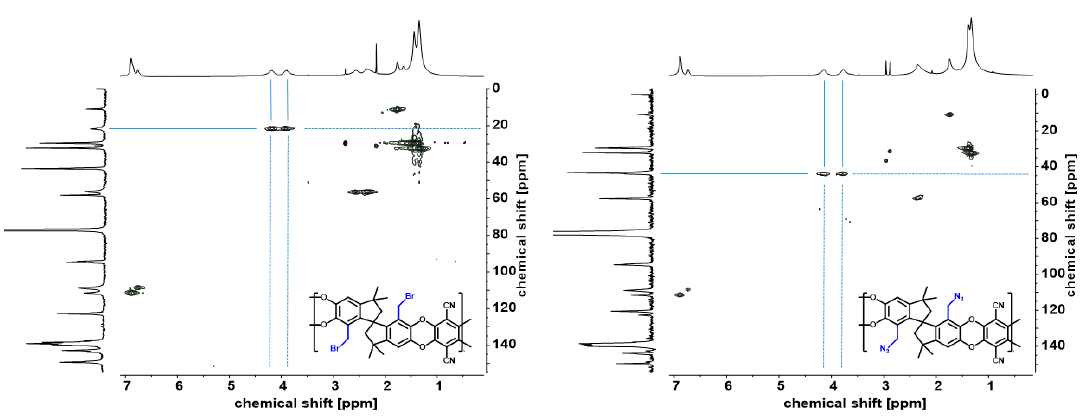
Figure 2. HSQC ( 1 H / 13 C) spectra of brominated homopolymer (PIM-Br-DMTTSBI-100, left) and azide substituted homopolymer (AZ-PIM-100, right).